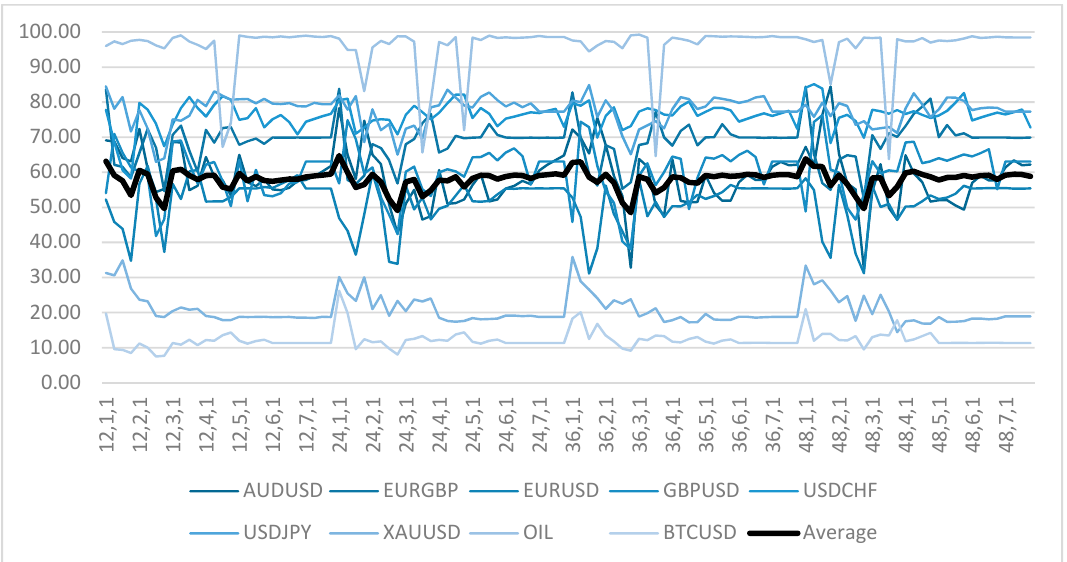
Figure 12. Net Profits of experiment (f) for various combinations of N, x , y .